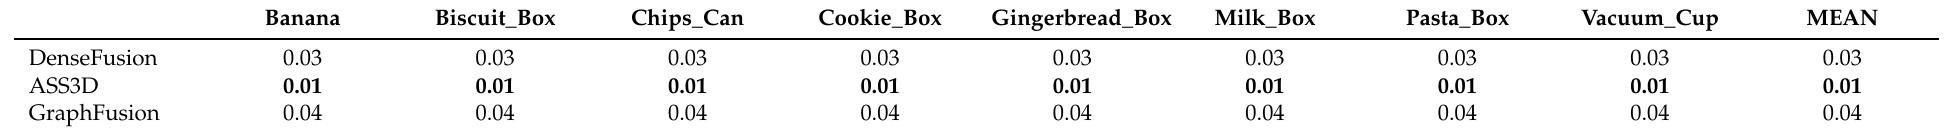
Table 8. Comparison of the computational run time among different approaches (second per